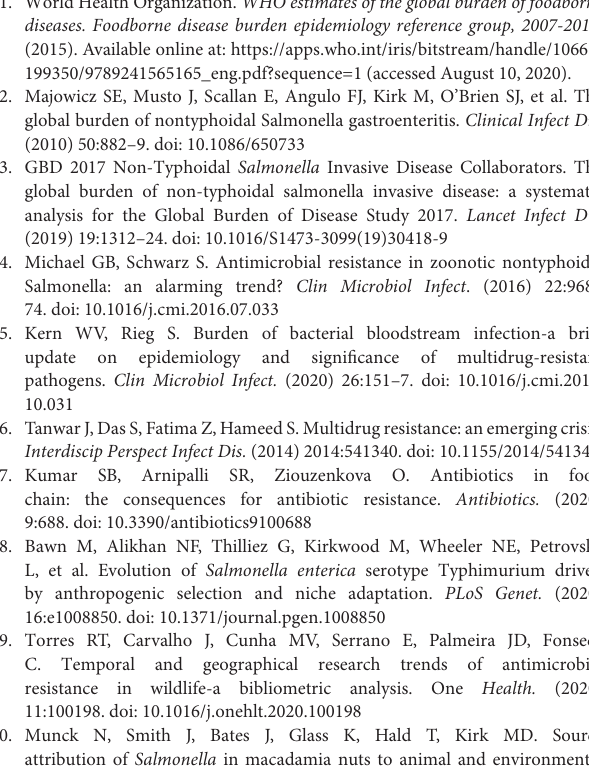
Salmonella enterica isolates from previous wildlife study.